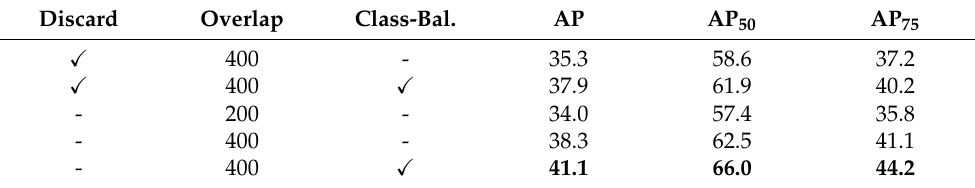
Table 6. Comparison of dataset preparation settings, i.e., w/ and w/o discarding of boxes with low IoU to the original box in the uncropped image and class-balanced resampling. The third line is the default data preparation strategy proposed by [52]. To prevent confusing the detector by unidentifiable objects during training, we discard objects which have a visibility of less than 50% in the experiments for the ablation studies. However, since the validation set includes such objects, discarding impairs the performance. The denser cropping strategy with only 200 pixel overlap in the application of the sliding window significantly increases the precision.